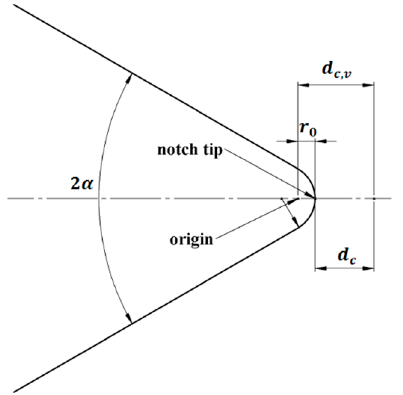
Figure 5. The critical distance d c,V in RV notches according to the MS criterion.